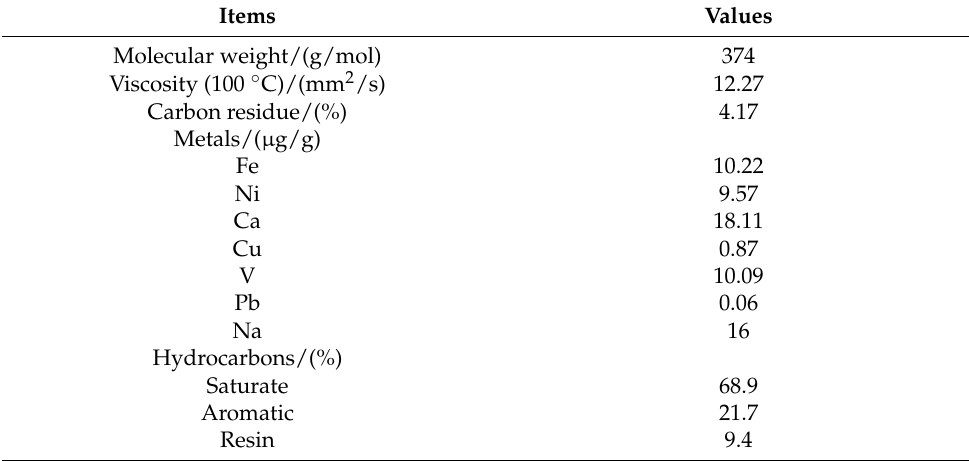
Table 1. Properties of heavy oil